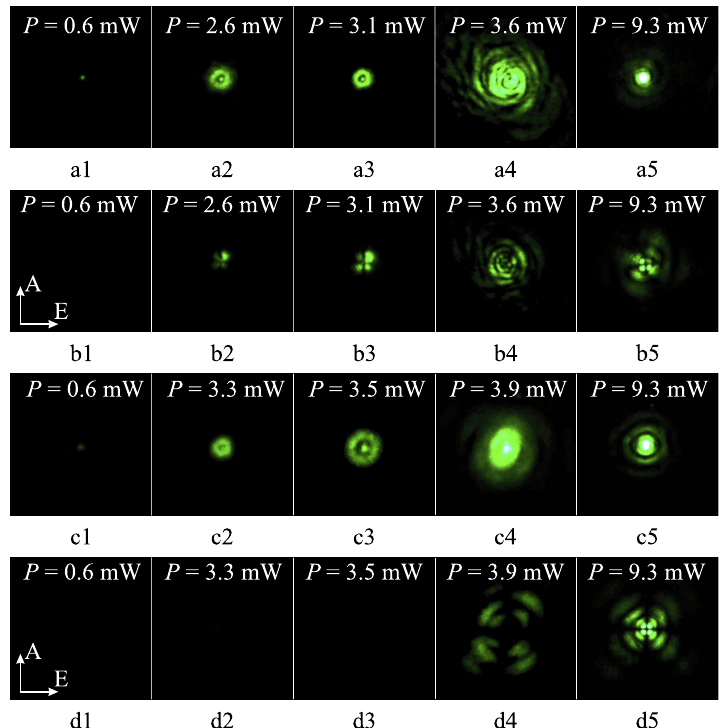
Figure 1. Far-field intensity distributions of the light beam passed through the homeotropically aligned films of 5CB + 0.2%MR + 0.025%BA ( a , b ) and 5CB + 0.2%MR ( c , d ) at different power P of incident light beam. Images ( b , d ) were obtained under cross-polarization conditions, when the transmission direction of the analyzer (A) placed after the sample was crossed with the direction of the electric field (E) in the incident light beam. The angular size of pictures equals 0.13